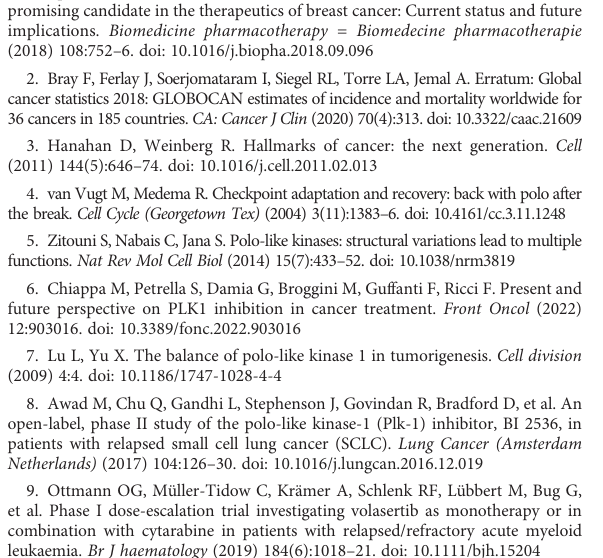
SUPPLEMENTARY FIGURE 1 PLK-1 expression with other information: (A) age; (B) gender; (C) tumor size; (D) distant